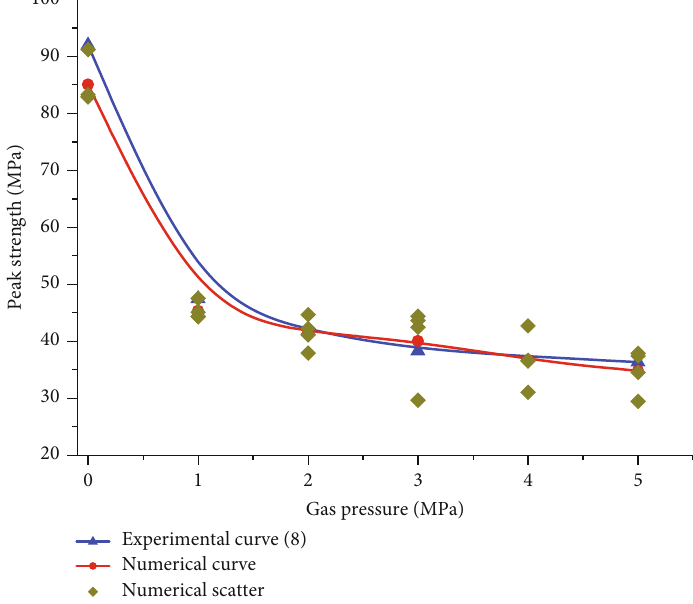
Figure 5: Variation of peak strength of coal sample with gas pressure.